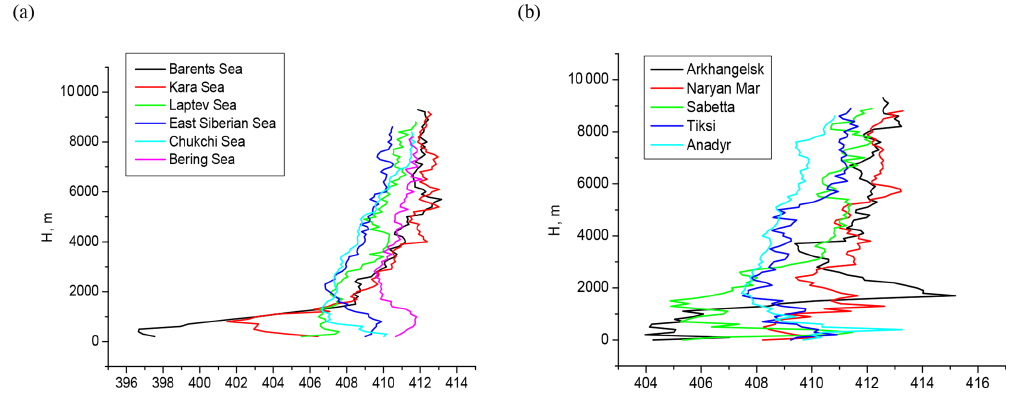
Figure 7. Vertical distribution of carbon dioxide over sea (a) and coastal areas (b)